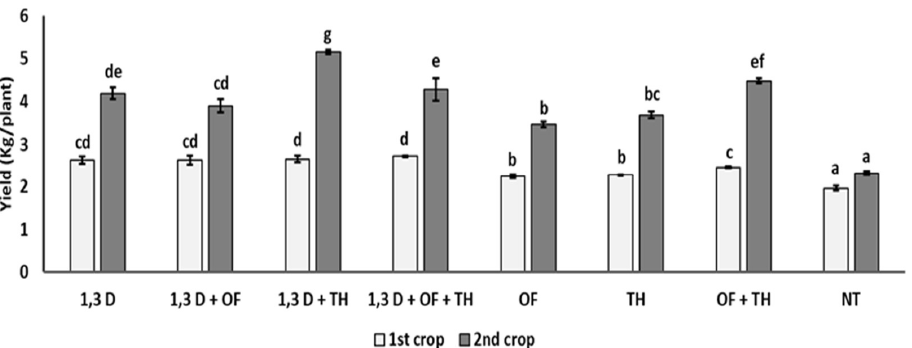
Figure 2. Effects of soil treatments with 1,3-dichloropropene (1,3-D), Trichoderma harzianum (TH) and an organic fertilizer (OF), either alone or in combination, on yield (kg/plant) of two consecutive tomato crops. NT = non-treated control. Bars show the average of n = 4 replicates per treatment ± S.E. Within each tomato crop, bars marked by the same letters are not significantly different, according to the least significant difference test ( p ≤ 0.05).